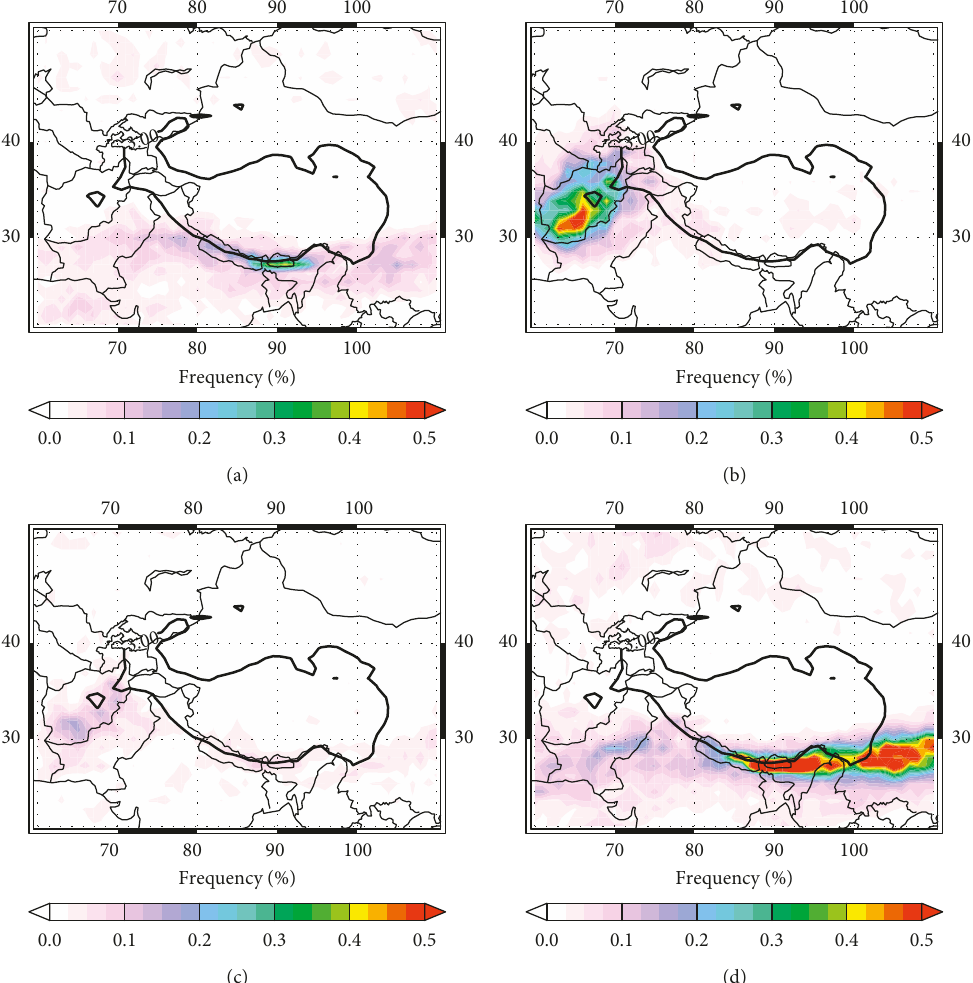
Figure 4: The same as Figure 3, but for medium tropopause fold frequencies.